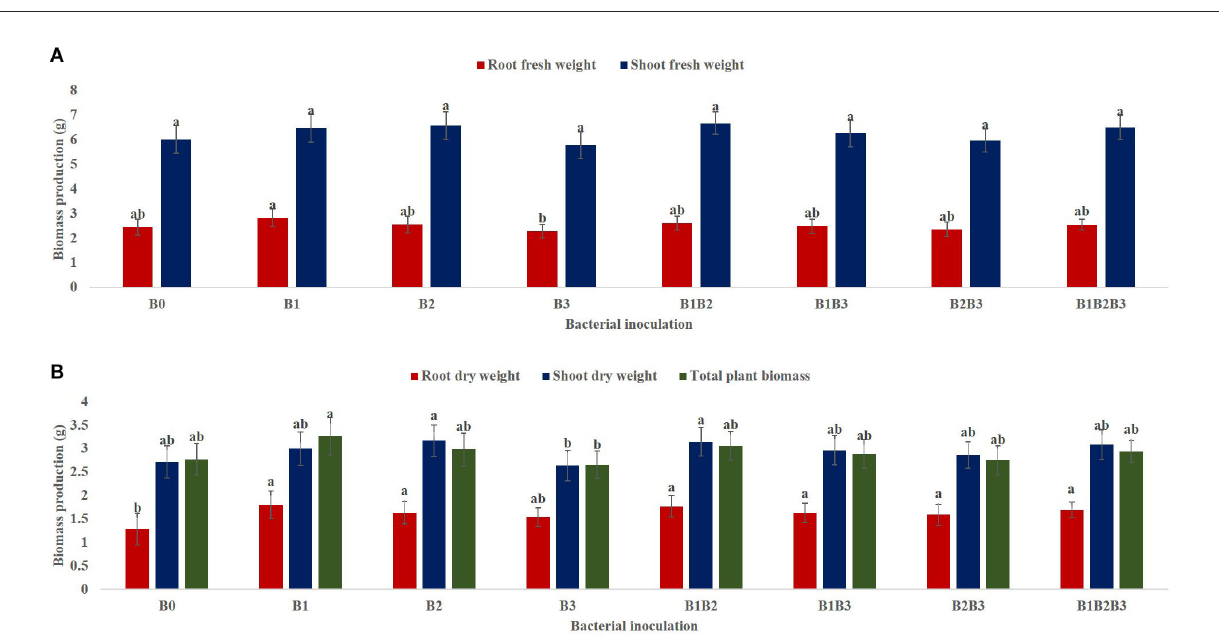
FIGURE2 Effect of bacterial inoculation on (A) shoot and root FW (B) root FW, shoot FW, and total plant biomass of maize plants. Values presented as means ± standard error ( n = 24). Means with different letters are significantly different from each other [Tukeys Honest Significant Difference ( p < 0.05)]. B 0 , un-inoculated control; B 1 , Pseudomonas sp. MRBP4; B 2 , Pseudomonas sp. MRBP13; B 3 , Bacillus sp. MRBP10; B 1 B 2 , Pseudomonas sp. MRBP4 + Pseudomonas sp. MRBP13; B 1 B 3 , Pseudomonas sp. MRBP4 + Bacillus sp. MRBP10; B 2 B 3 , Bacillus sp. MRBP10 + Pseudomonas sp. MRBP13; B 1 B 2 B 3